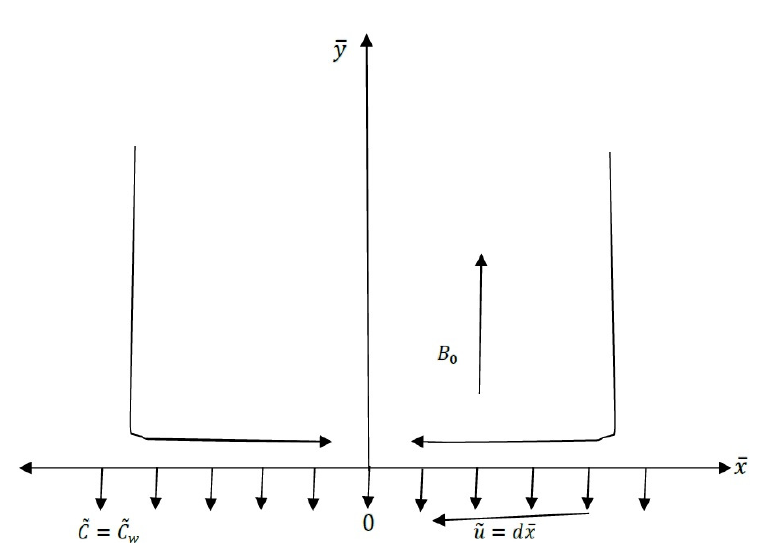
Figure 1. Geometry of the flow problem and coordinate system.